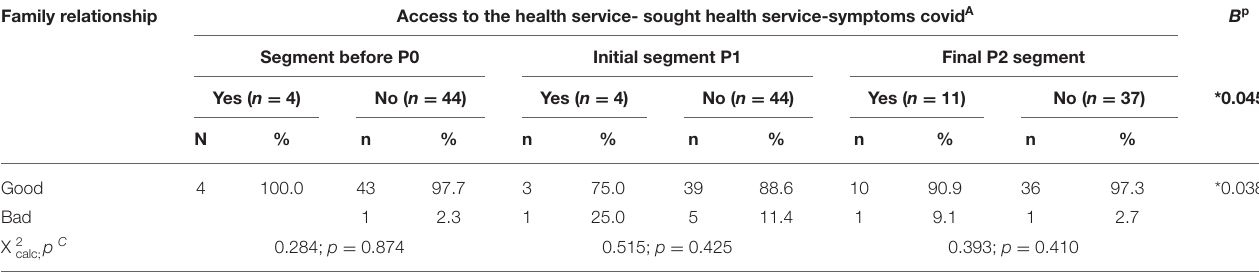
TABLE 5 | Absolute and relative distribution for “access to health services” in the initial (P1) and final (P2) segments according to the family relationship. Family